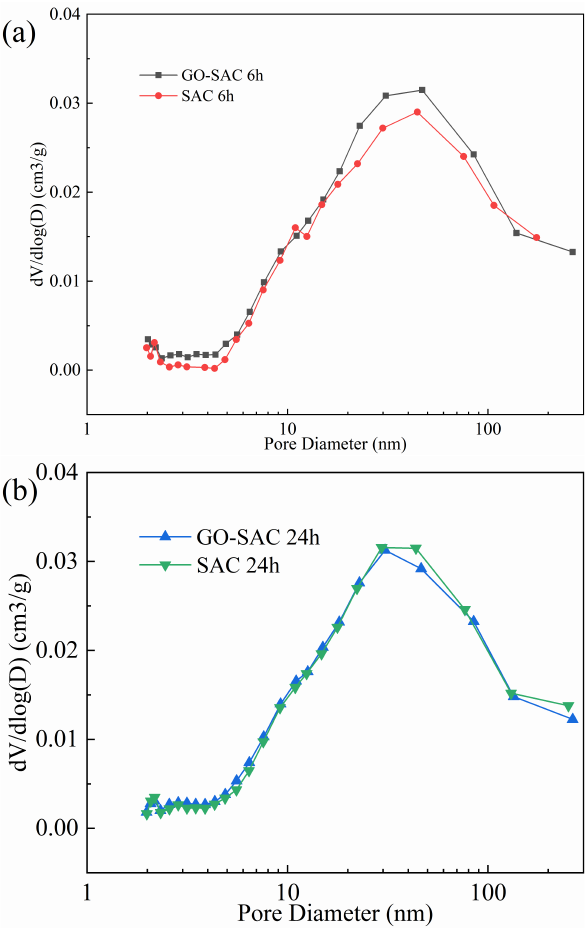
Figure 4: Pore size distribution of SAC and GO-SAC: (a) at 6 h; (b) at 24